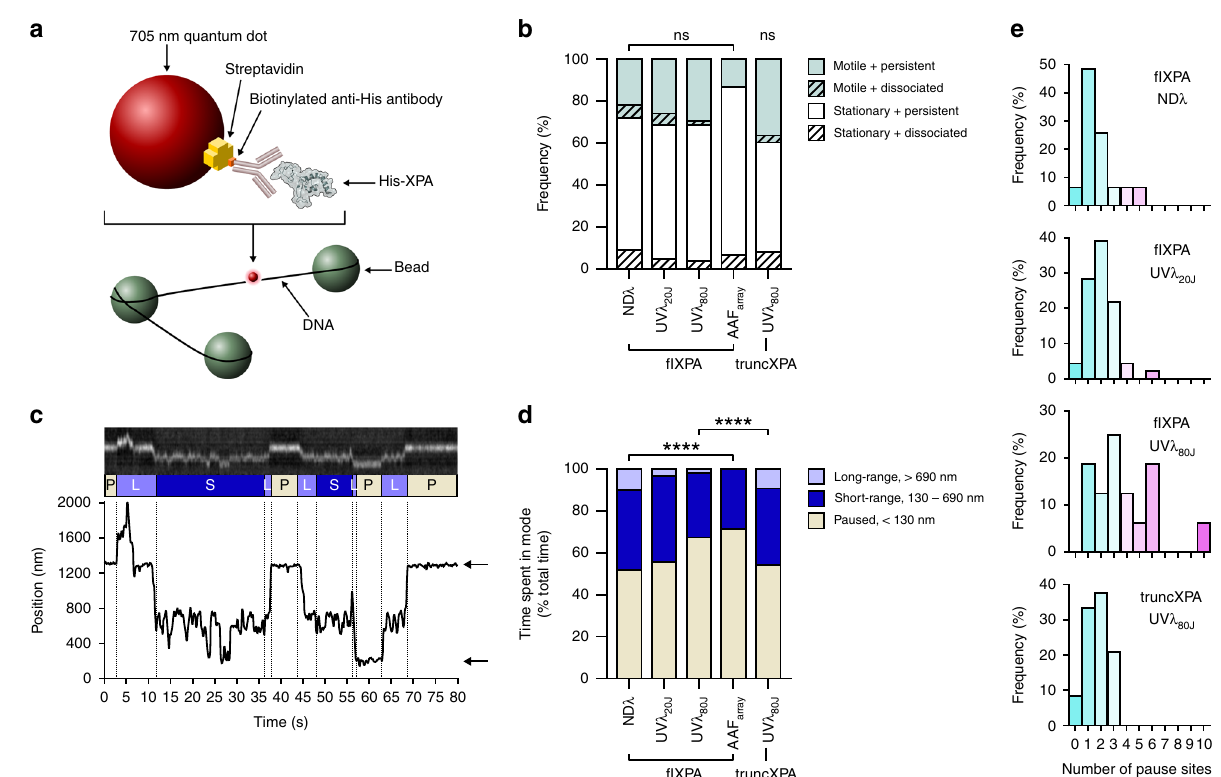
Fig. 5 XPA exhibits episodic linear diffusion on DNA tightropes. DNA damage leads to increased pausing, dependent on N- and C-termini. a Cartoon showing one strategy used for XPA labeling on DNA tightropes. His-tagged XPA is labeled with a biotinylated anti-His antibody bound to a streptavidin- conjugated 705 nm quantum dot. See Methods for alternative labeling strategy. b Stacked bar graph showing the fraction of motile (teal) vs. stationary (white) and persistent (solid) vs. dissociating (diagonal lines) particles of full-length XPA ( fl XPA) on non-damaged λ (ND λ , n = 124 particles), 20J/m 2 UV- irradiated λ (UV λ 20J , n = 147), 80 J/m 2 UV-irradiated λ (UV λ 80J , n = 54), and AAF arrays (AAF array , n = 45), and of truncated XPA (truncXPA) on UV λ 80J ( n = 63). Motile particles are de fi ned as those which moved more than 130 nm on DNA during 300s observation. ns, no signi fi cant difference between groups by χ 2 for all fl XPA experiments, for all fl XPA and truncXPA categories, or for truncXPA on UV λ 80J vs. fl XPA on UV λ 80J . c Example of a kymograph (cut to show only 80 s of the recorded movie) of motile 705 nm quantum dot-labeled fl XPA on ND λ . Particle position (bottom) was localized using Gaussian fi ttings to the intensity pro fi le on the fl uorescence image (top). Dashed lines separate phases and diffusive modes are labeled according to particle displacement: paused (P, displacement <130 nm, tan), short-range motion (S, displacement 130 – 690 nm, navy), and long-range motion (L, displacement > 690 nm, lavender). Arrows point to pause sites occupied by particle. d Stacked bar graph showing the fraction of time spent in each mode as percentage of total time recorded for all motile particles. **** p < 0.0001 by χ 2 for all fl XPA experiments and for truncXPA on UV λ 80J vs. fl XPA on UV λ 80J . e Histogram of number of pause sites for fl XPA on ND λ ( n = 31 particles), UV λ 20J ( n = 46), and UV λ 80J ( n = 16), and for truncXPA on UV λ 80J ( n =